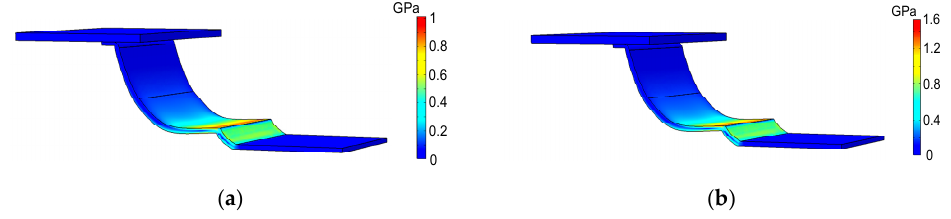
Figure 6. Stress distributions of the models with ( a ) copper and ( b ) gold-plated NiW.